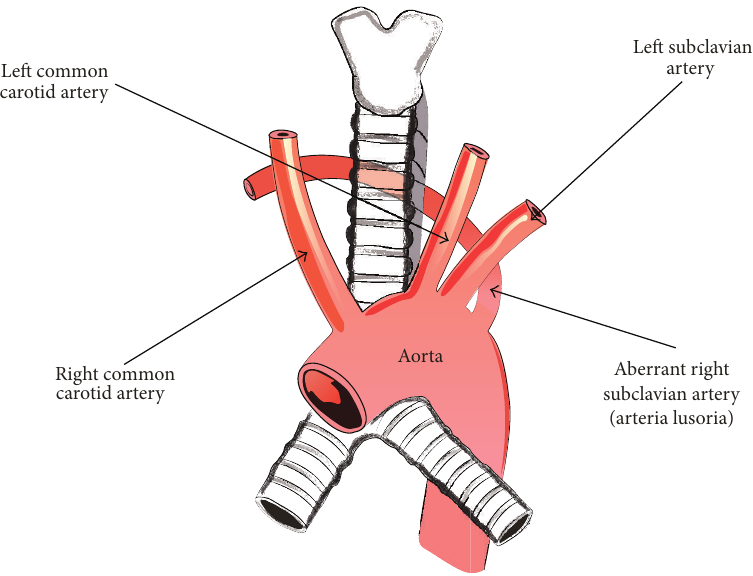
Figure 2: Schematic arrangements of the presence of an aberrant right subclavian